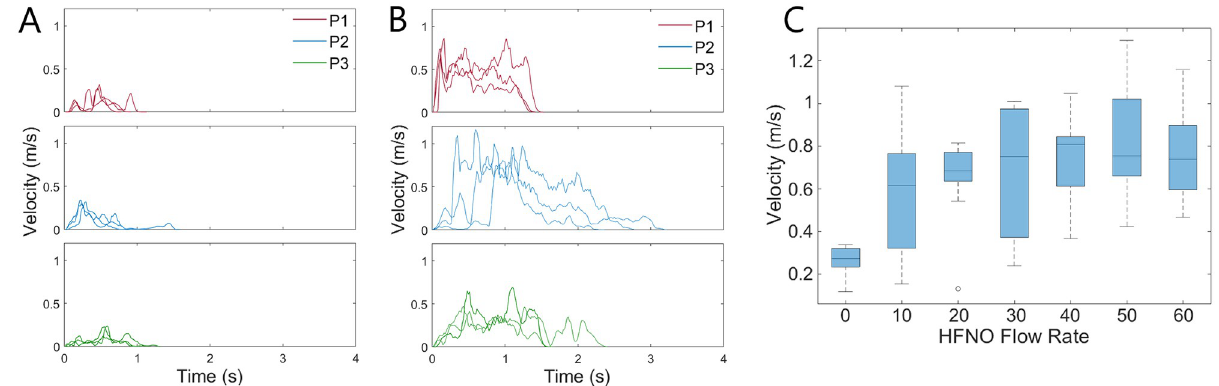
Fig 5. Schlieren coughing trials. Velocity during a single cough for (A) unassisted breathing and (B) HFNO at 60 L/min for each participant. (C) Range of maximum cough velocities for all participants. Box and whisker plots show median and interquartile ranges for the data set.